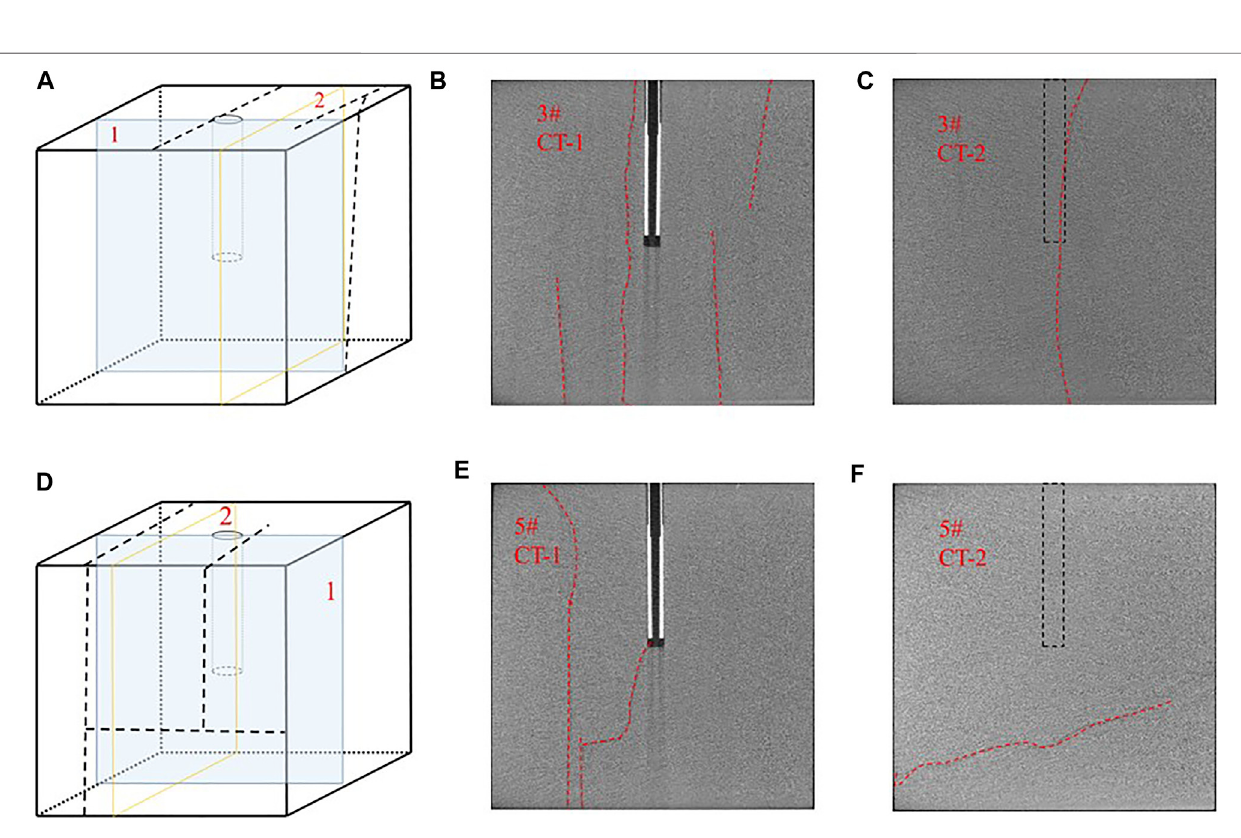
Frontiers in Energy Research |